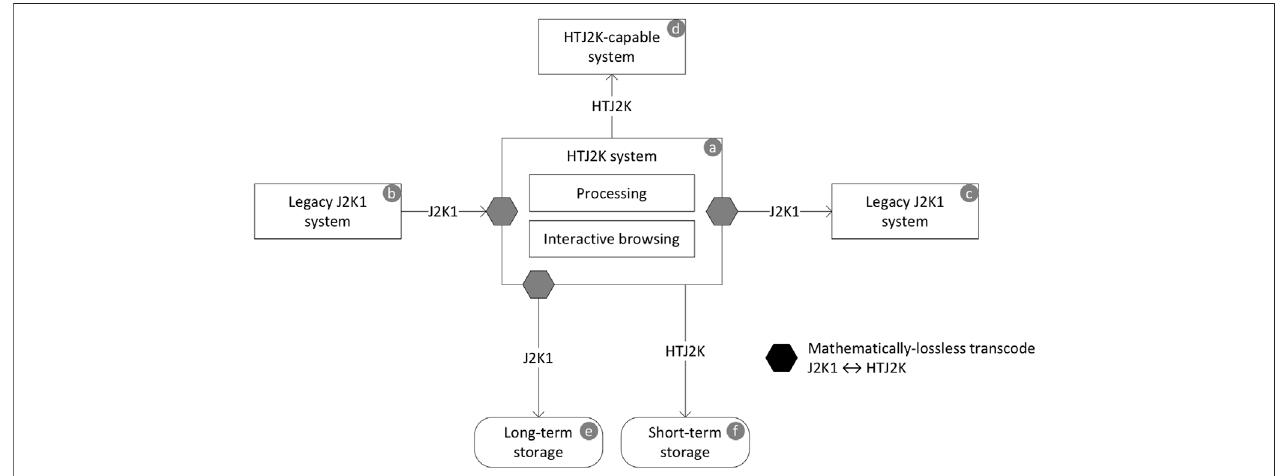
FIGURE 12 | The ability to transcode HTJ2K to/from J2K1 mathematically losslessly allows an HTJ2K work fl ow to retaining compatibility with legacy J2K1 systems.